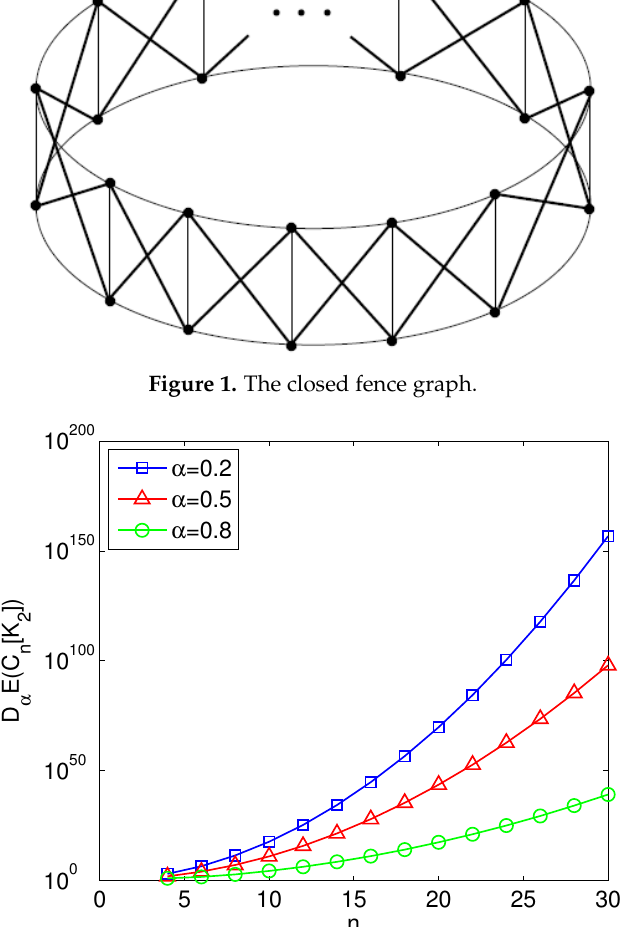
Figure 2. D α E ( C n [ K 2 ]) versus n for different values of α